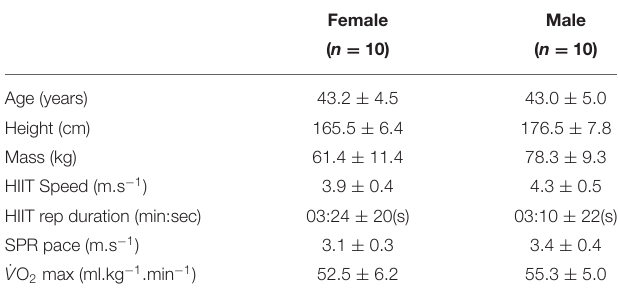
TABLE 1 | Descriptive characteristics of participants along with speeds,